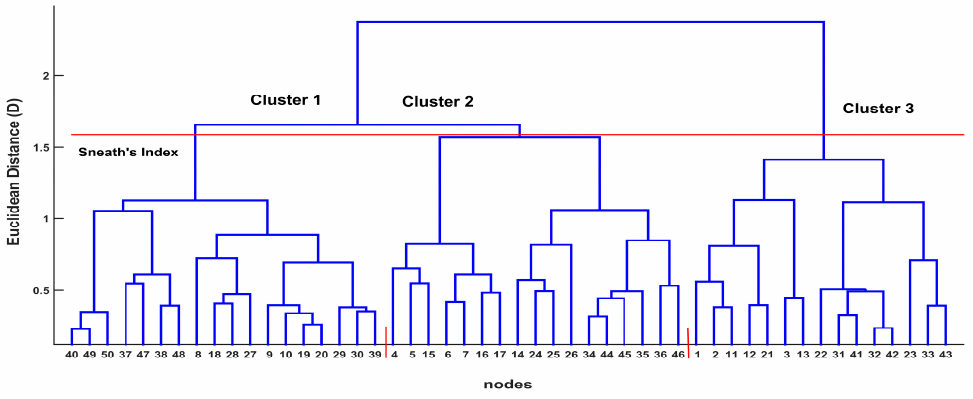
Figure 8. A dendrogram of similarity for the SOM’s prototype nodes. Based on Sneath’s less restrictive criterion (red horizontal line), three clusters are formed (separated by the red vertical solid lines).